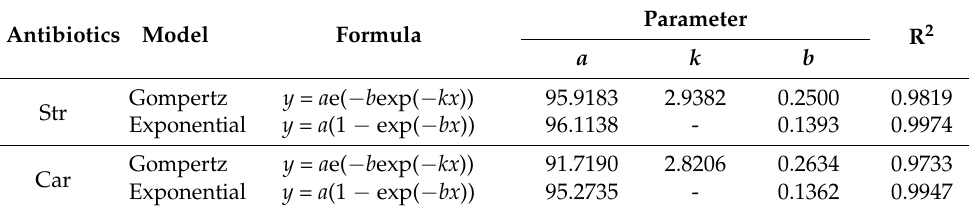
Table 4. Gompertz model and exponential model fitted Str and Car bacteriostasis results. Antibiotics